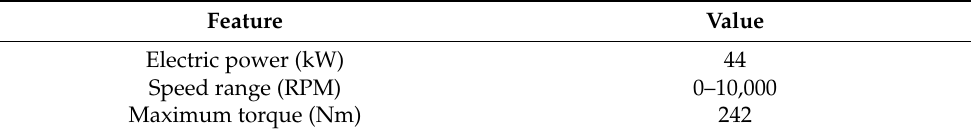
Table 21. Five-axis CNC center’s main features necessary for the CF calculation [73].